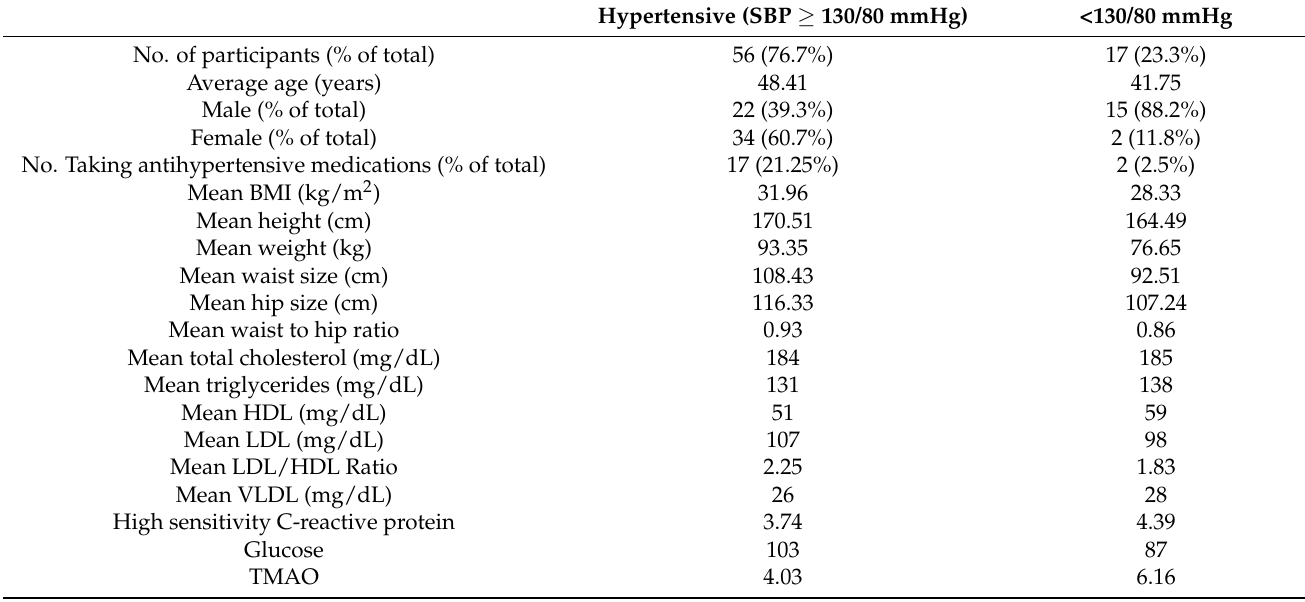
Table 2. Baseline characteristics of hypertensive versus normotensive participants at day 0. Body mass index, BMI; Systolic blood pressure, SBP; diastolic blood pressure, DBP; high density lipoprotein, HDL; low density lipoprotein, LDL; very low density lipoprotein, VLDL; trimethylamine N-oxide,